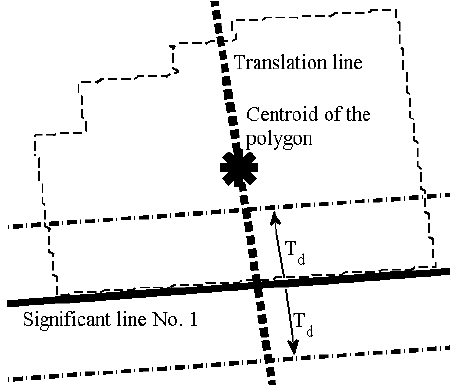
Fig. 4. Translation of the significant line